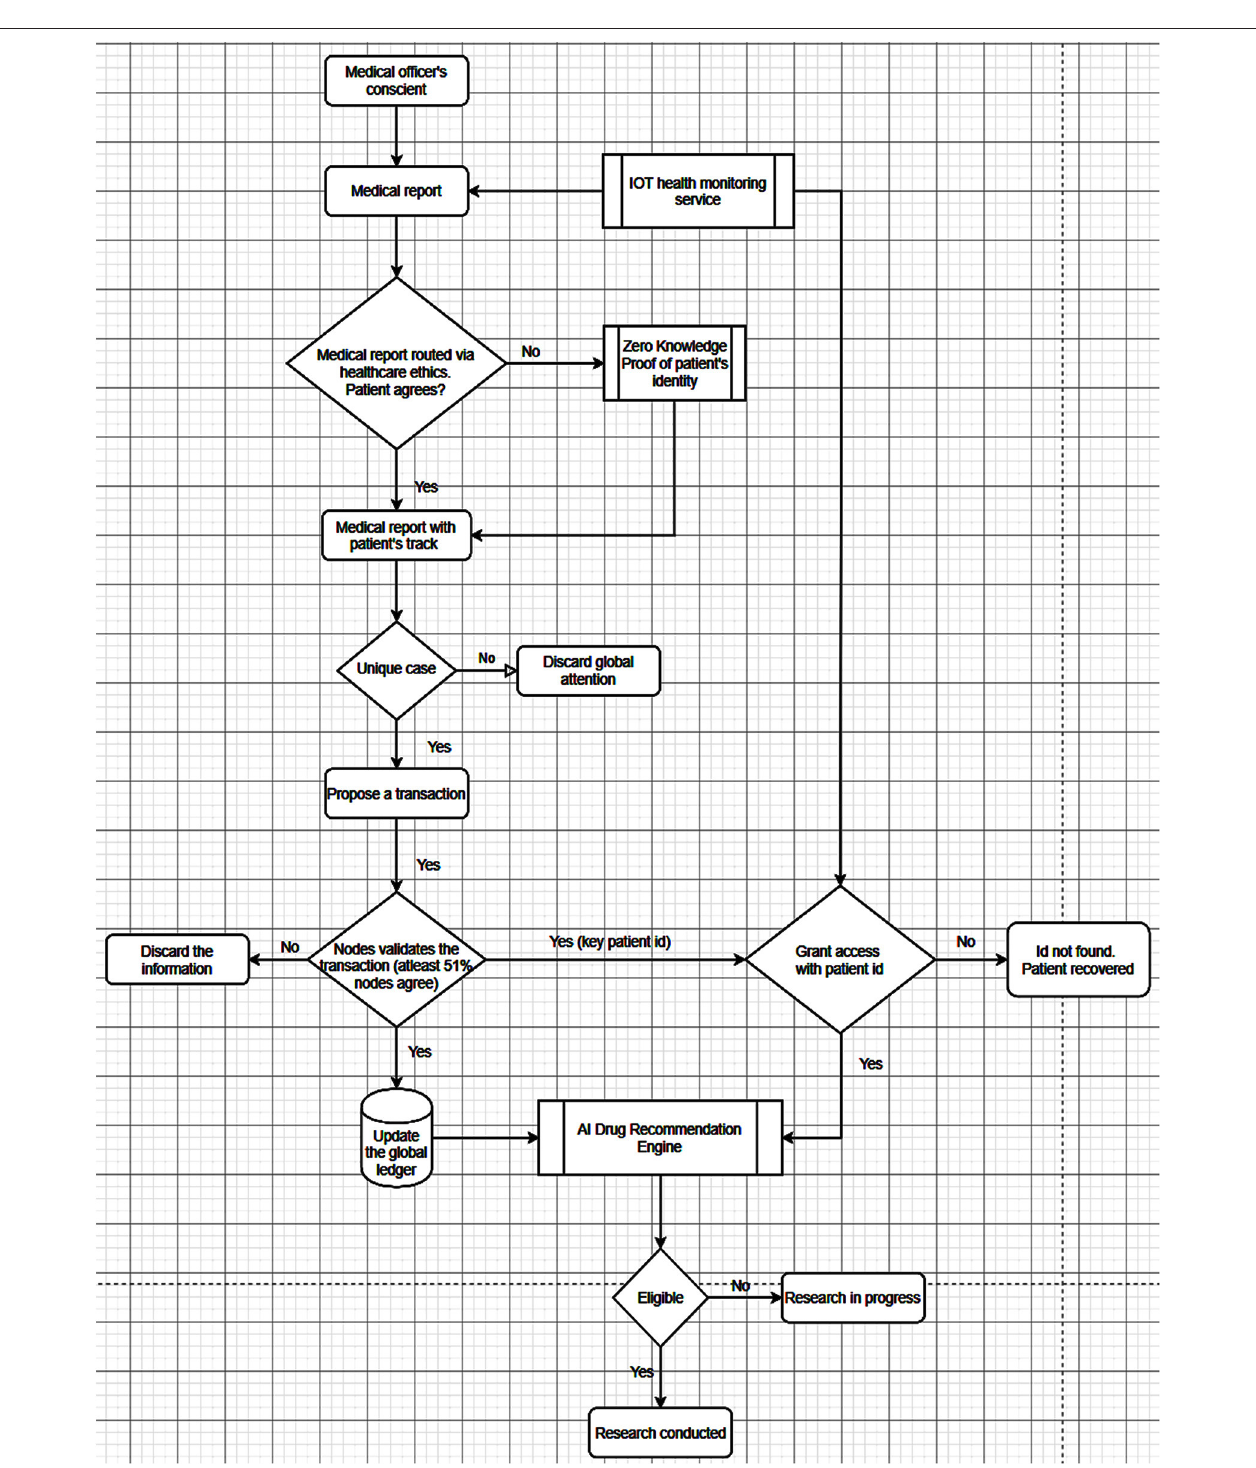
FIGURE 2 | A solution to overcome the misdemeanor at the setting/country/global health organization level and the authentication of news in global media/publication. A unique medical information/case is proposed as a transaction to the nodes to be shared among peers. If the nodes find it legitimate, then they validate the transaction and update the global state of the ledger. The ledger grants the access of health monitoring data to the AI Drug Recommendation Engine by mapping the patient’s ID as key to delve into the history of chain data for future recommendations by tracing the drugs used in the past for its cure. Here A, B, C, and